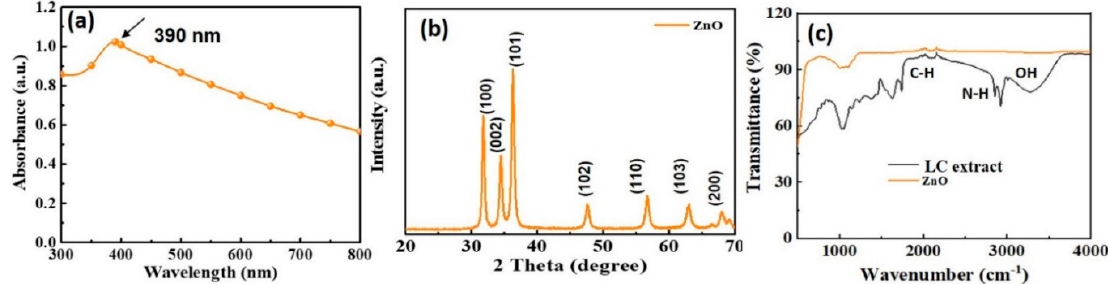
Figure 1. UV-Vis spectra of ( a ) LC-ZnO/OF and XRD spectra of ( b ) and FTIR spectra of ( c ).